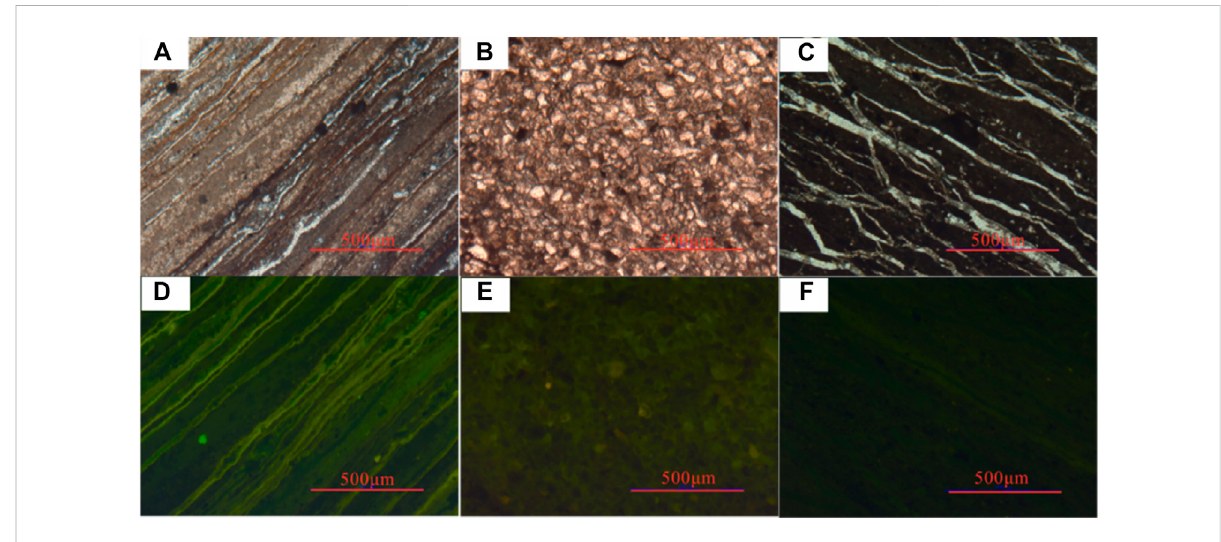
FIGURE 9 Microscopic characteristics of different shale facies of Shahejie Formation in the northern Dongpu Depression.